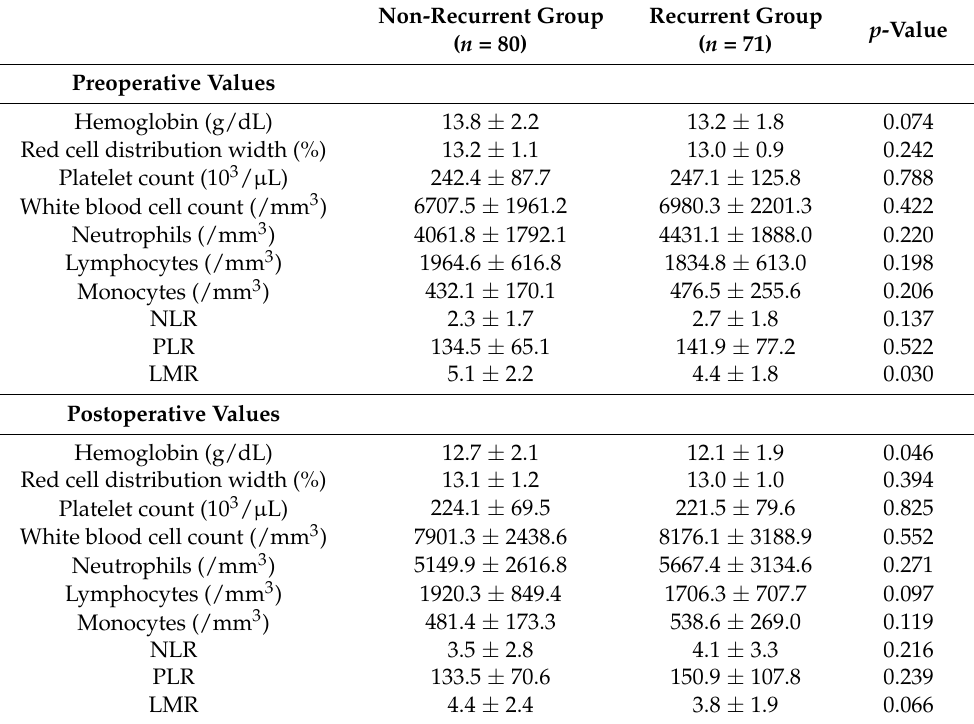
Table 2. Preoperative and postoperative peripheral blood